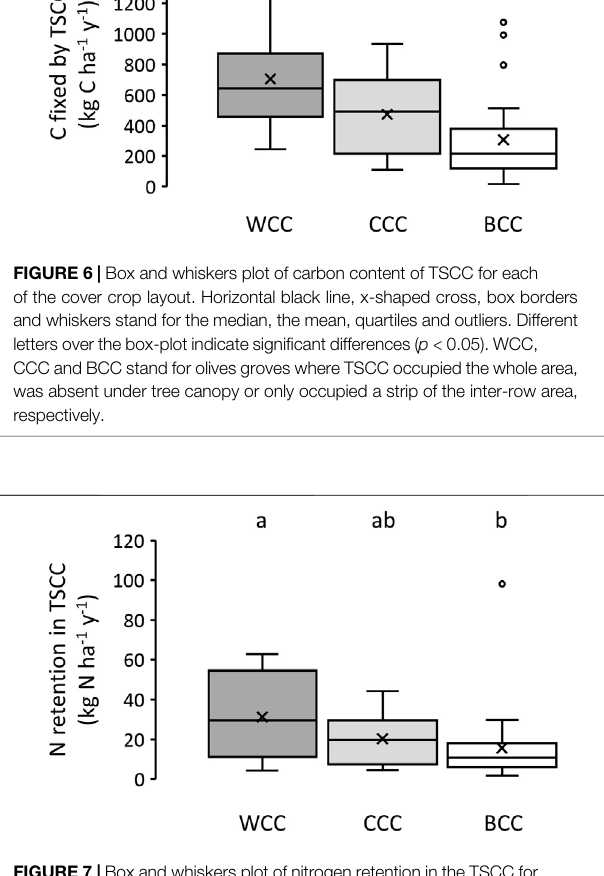
( Figure 6 ). As for the ANPP, the fi xed carbon of the TSCC under WCC (704.9 kg C ha − 1 y − 1 or 2,584.6 kg CO 2 ha − 1 y − 1 ) and under CCC (475.3 kg C ha − 1 y − 1 or 1,742.8 kg CO 2 ha − 1 y − 1 ) were signi fi cantly higher than that under BCC (305.7 kg C ha − 1 y − 1 or 1,120.9 kg CO 2 ha − 1 y − 1 ). No differences were found between CCC and WCC